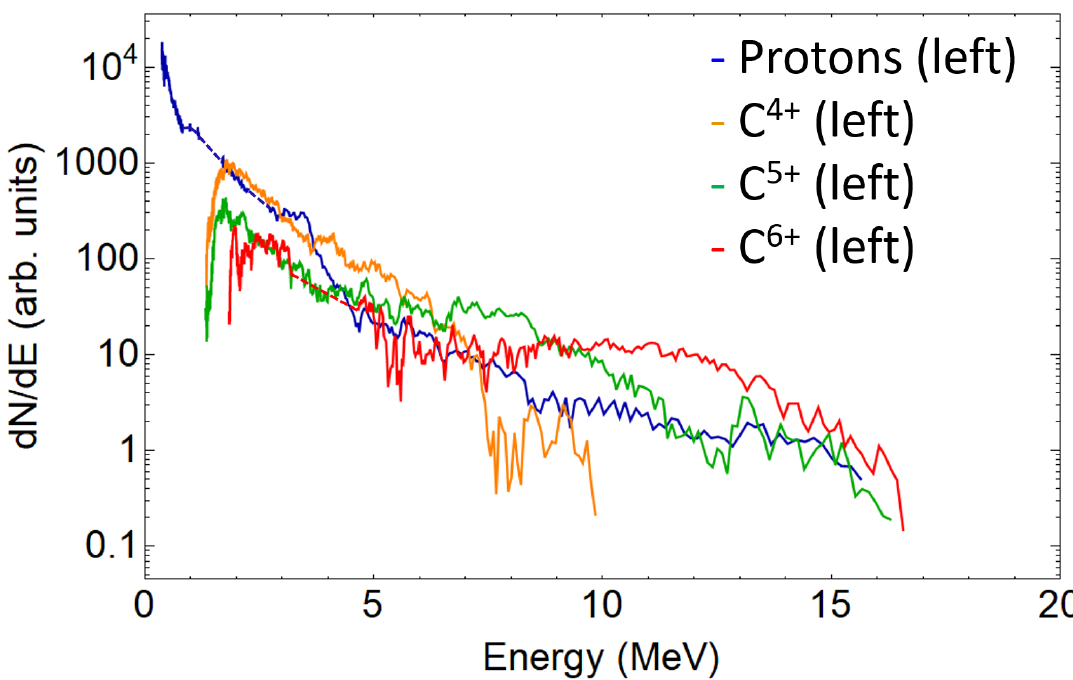
Figure 7. Left beamlets spectra for protons and C 4 + , C 5 + , and C 6 + ions in the logarithmic scale. Dashed lines show the reconstructed spectrum